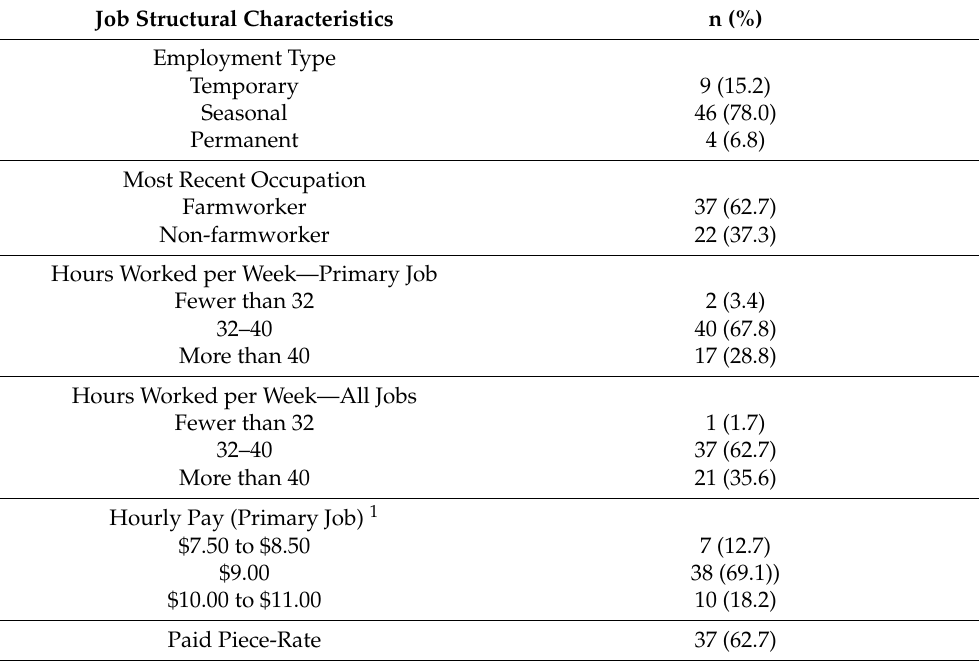
Table 4. Job Structural Characteristics of Participants Employed in the Past Year at Follow-Up 5 Questionnaire, Latinx Women in Farmworker Families, North Carolina (N = 59).